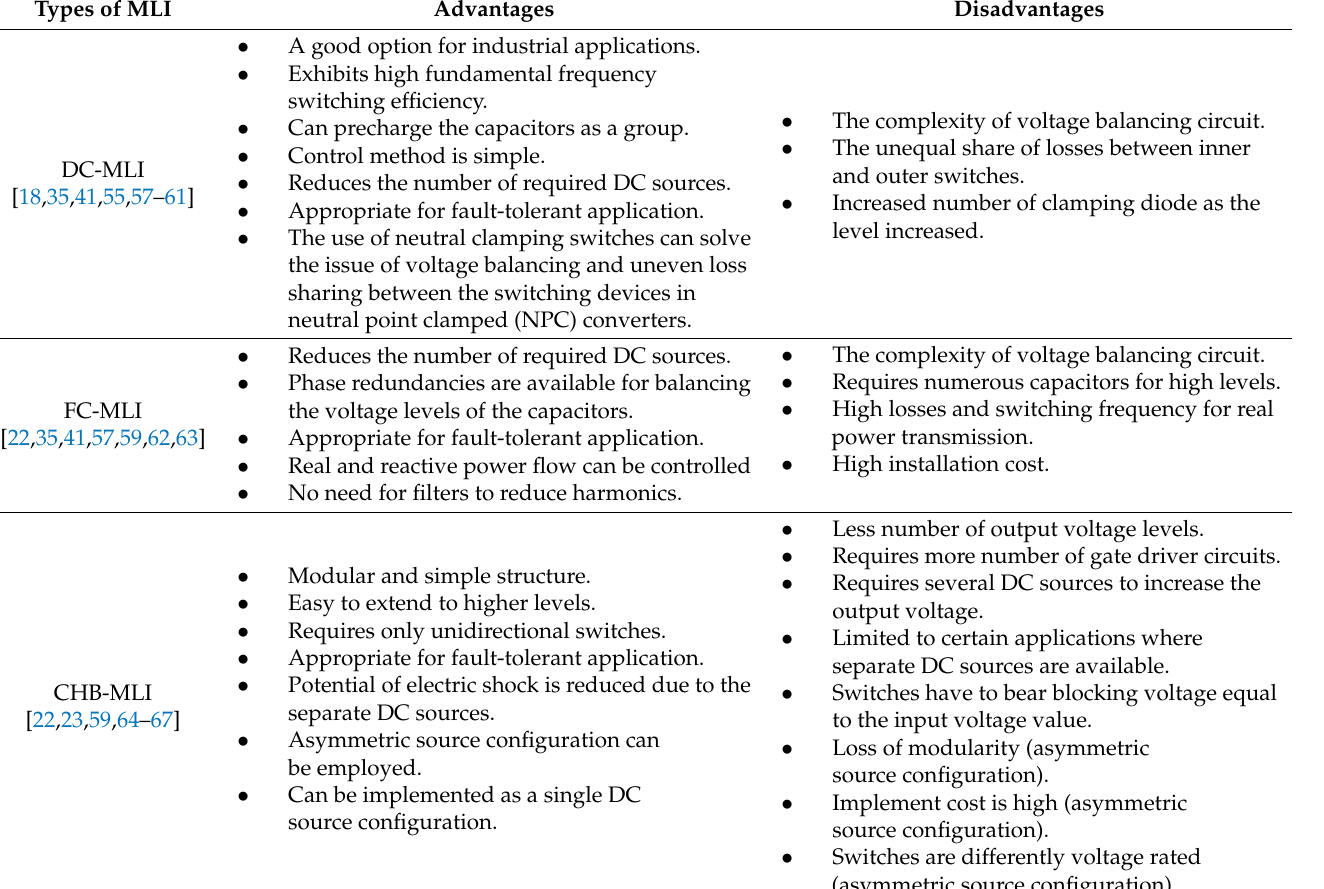
Table 1. Advantages and disadvantages of the classical topologies (DC-MLI, FC-MLI, and CHB-MLI). Types of